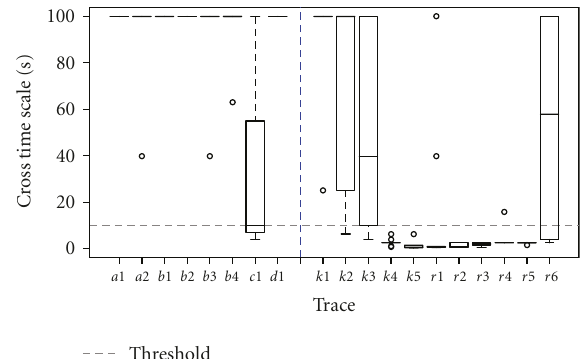
Figure 16: Bot identification results using the burstiness magnitude method.